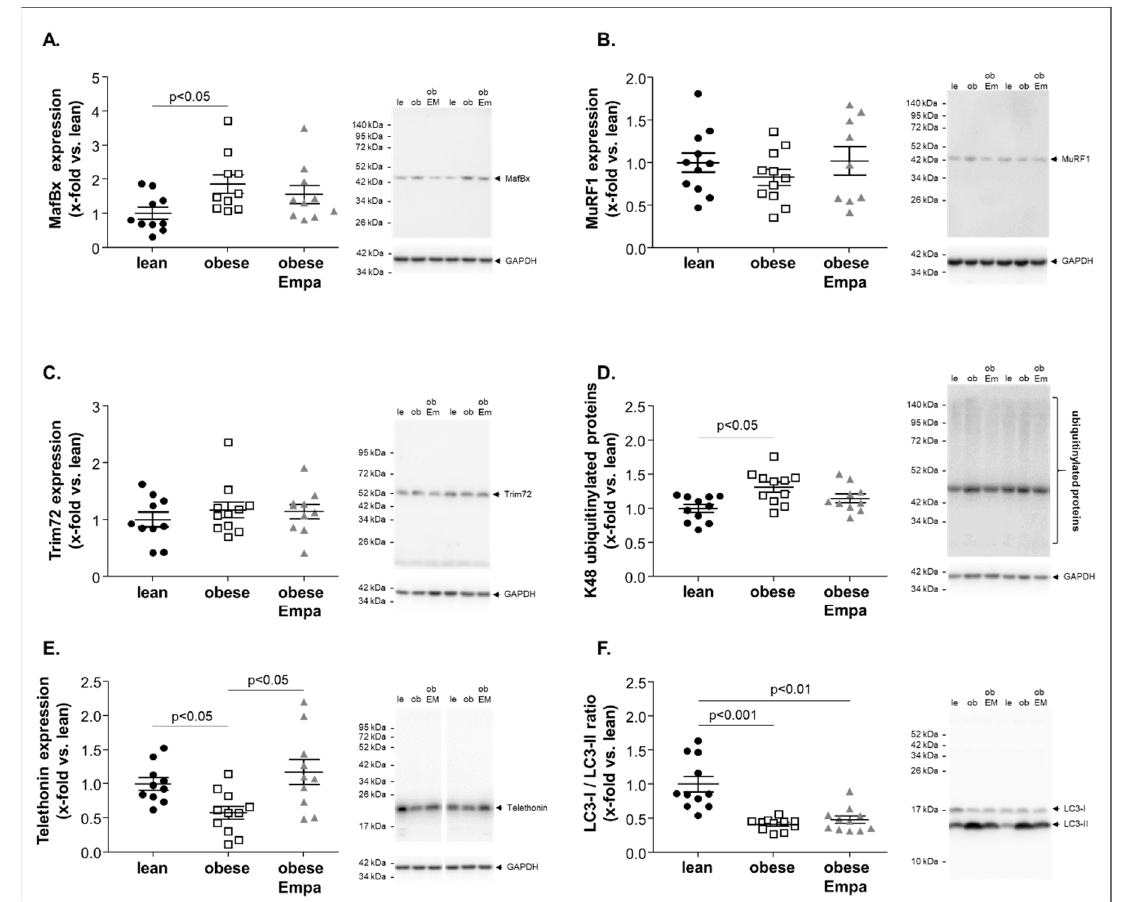
Figure 3. Protein expression of atrophy-related proteins ( A – F ) were quantified by western blot analysis in soleus muscle homogenates obtained from ZSF1-lean (lean, black circles), ZSF1-obese (obese, open squares) and ZSF1-obese rats treated with Empagliflozin (obese + Emp), grey triangle). As atrophy related proteins Muscle Atrophy F-Box (MAFBx) ( A ), muscle RING-finger protein-1 (MuRF1) ( B ), Tripartite Motif-containing Protein 72 (Trim72) ( C ), ubiquitinylated proteins ( D ), telethonin ( E ) and LC3B were measured. Results are expressed as mean ± SEM ( n = 10–11 per group). Representative western blots are depicted.